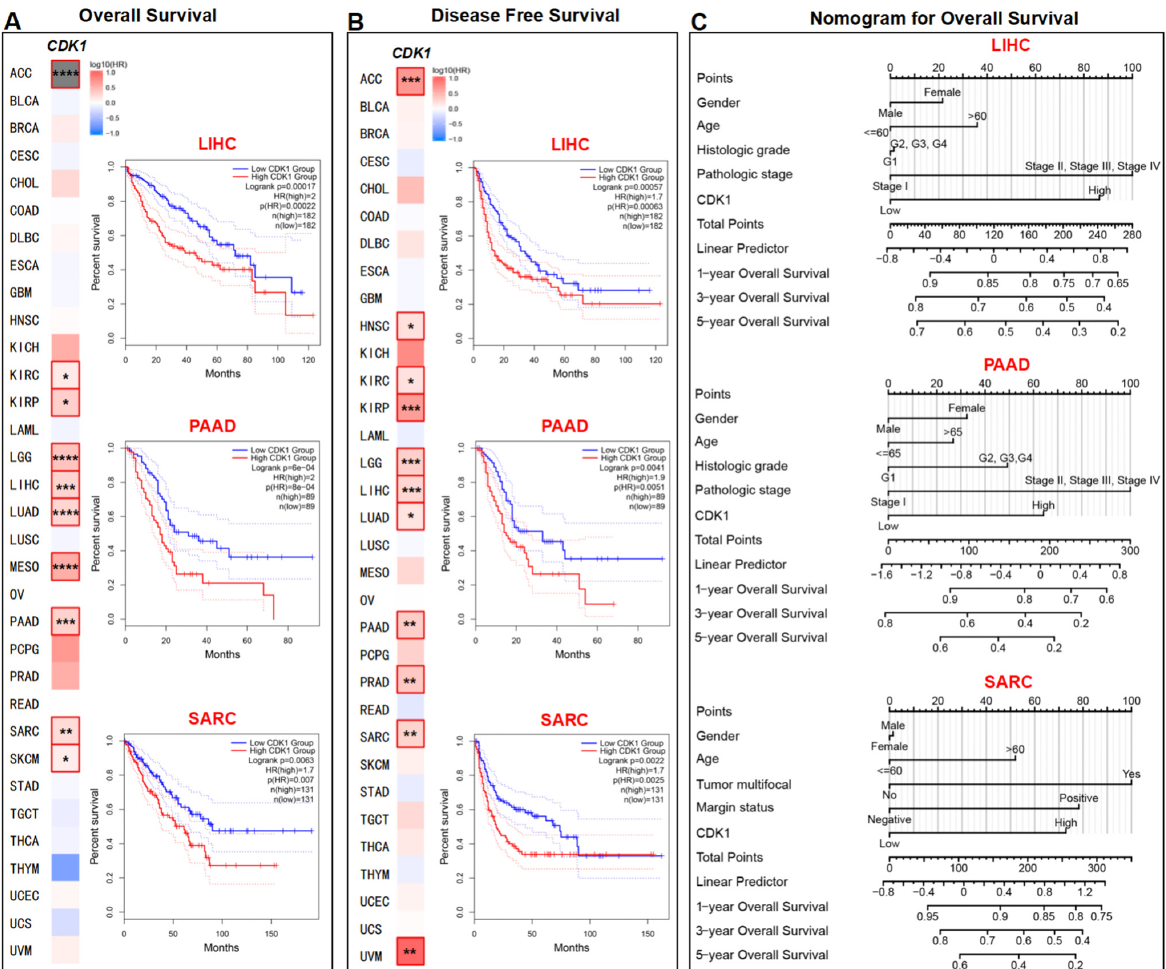
Figure 4. Correlation between CDK1 expression and survival in different tumors. Survival maps of different tumors and Kaplan–Meier curves of LIHC, PAAD, and SARC are given. High CDK1 expression was correlated with ( A ) overall survival and ( B ) disease-free survival in multiple tumors from the TCGA database. ( C ) Nomograms predicting one-, three-, and five-year overall survival of LIHC, PAAD, and SARC. Variables include gender, age, histological grade, pathologic stage, tumor multifocal, margin status, and CDK1 expression. * p < 0.05, ** p < 0.01, *** p < 0.001, **** p < 0.0001, log-rank test. HR: hazard ratio.